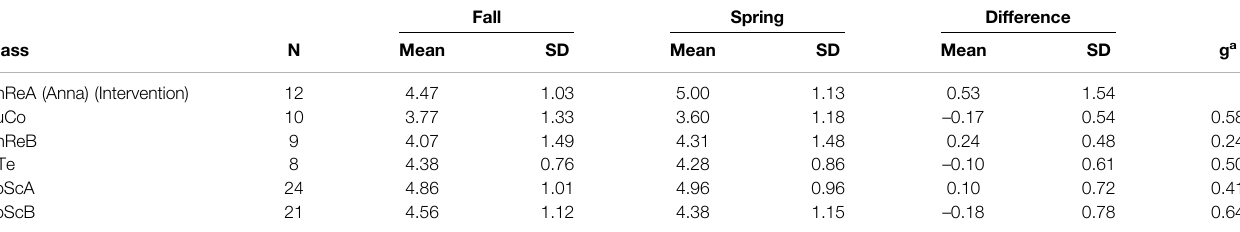
TABLE 2 | Behavioral engagement in the intervention and comparison classes in the fall and spring and their difference. Fall Spring Difference Class N Mean SD Mean SD Mean SD g a